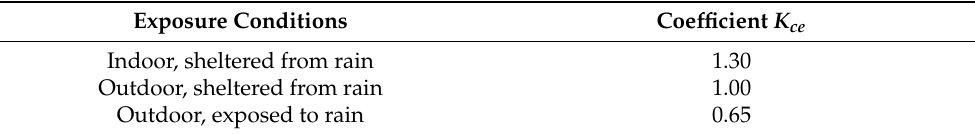
Table 2. Model coefficients as a function of exposure conditions